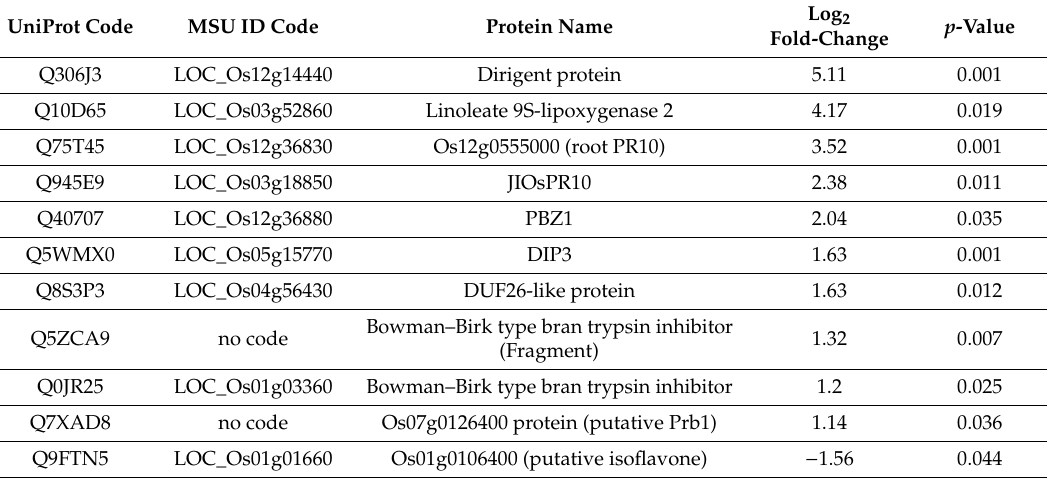
Table 2. Di ff erentially expressed proteins (DEPs) after wounding, compared to